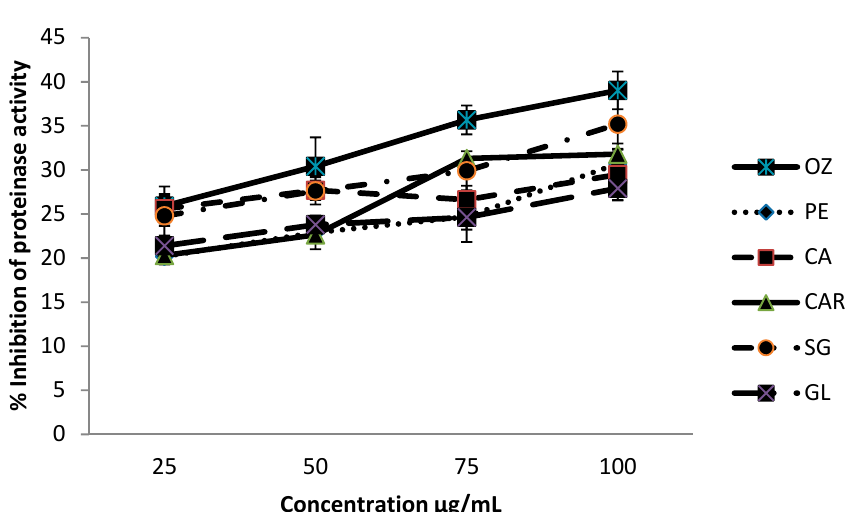
Figure 3. Proteinase inhibitory activity of green leafy vegetables. Values represent means of triplicate readings. CAR— C. auriculata ; GL— G. lactiferum ; OZ— O. zeylanica ; PE— P. edulis ; CA— C. asiatica ; SG— S. grandiflora . Data are presented as the means ± standard deviations of three replicate determinations. Results for lipoxygenase inhibitory activity of different leafy vegetables are shown graphically in Figure 4.